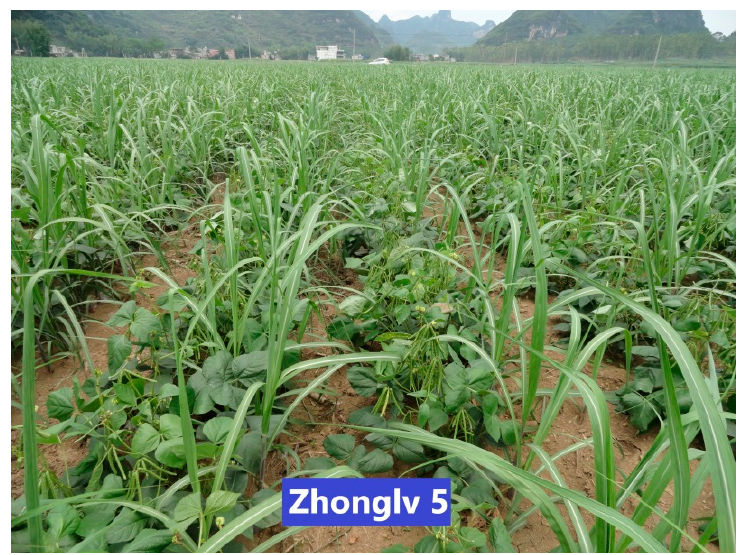
Figure 1. Intercropping of mung bean with sugarcane. Table 2. Zhonglv 5 yields in intercropping systems from 2013 to 2019.